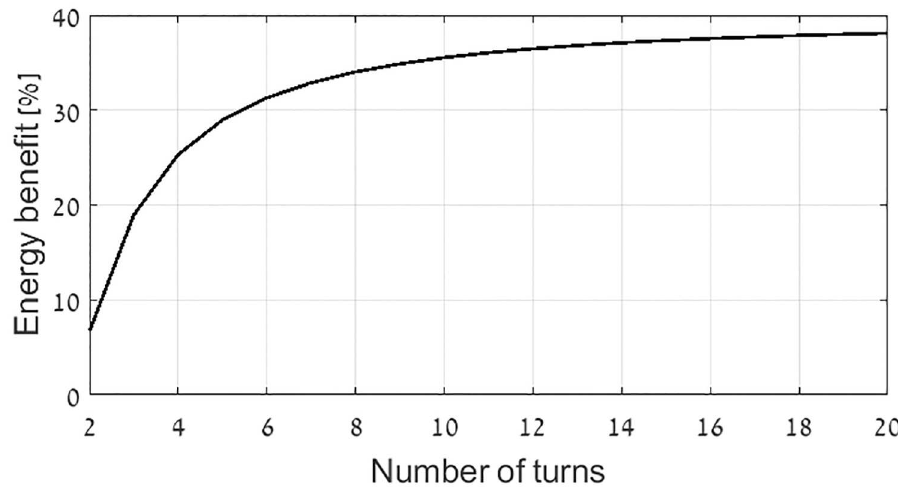
Fig 7. Energy benefit of optimal spiral flat coil over constant current single layer flat